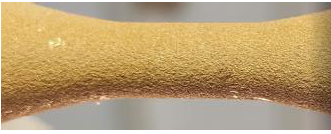
Figure 12. Sample H — unbroken after over 5 million cycles; σ = 346 MPa, n = 5,000,099 cycles.